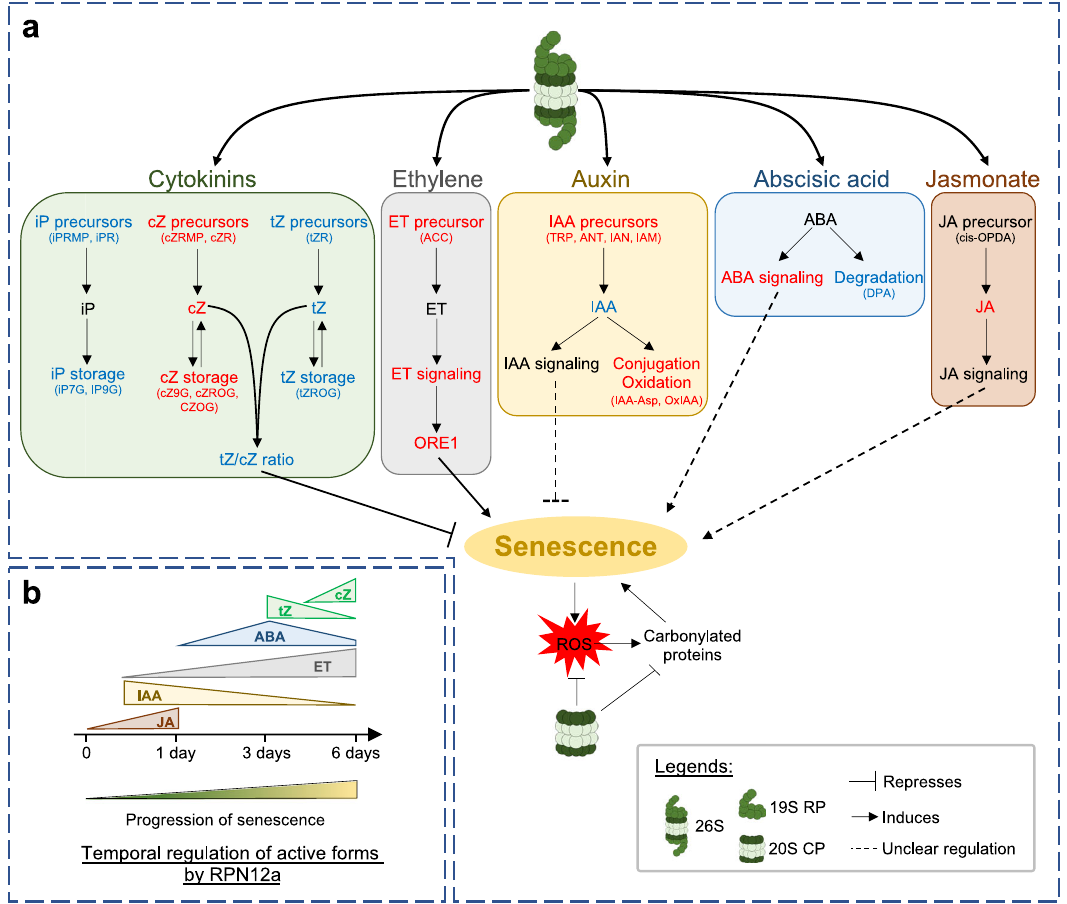
proteasome greatly impacts the cytokinins, ethylene, abscisic acid and auxin biosynthesis and signaling pathways. For instance, the tZ/cZ ratio